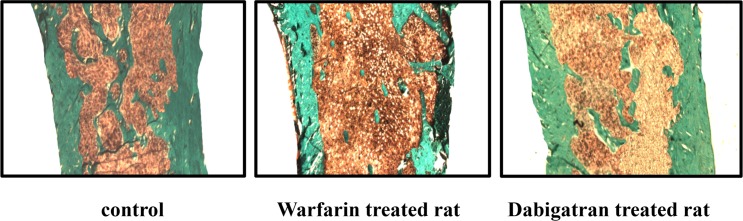
Dabigatran preserves femur volume and structure.Note the higher bone volume and trabecular thickness with lesser trabecular separation in rats treated with dabigatran compared to rats treated with warfarin. Bone of a representative normal control rat is also shown. (magnification 100X).